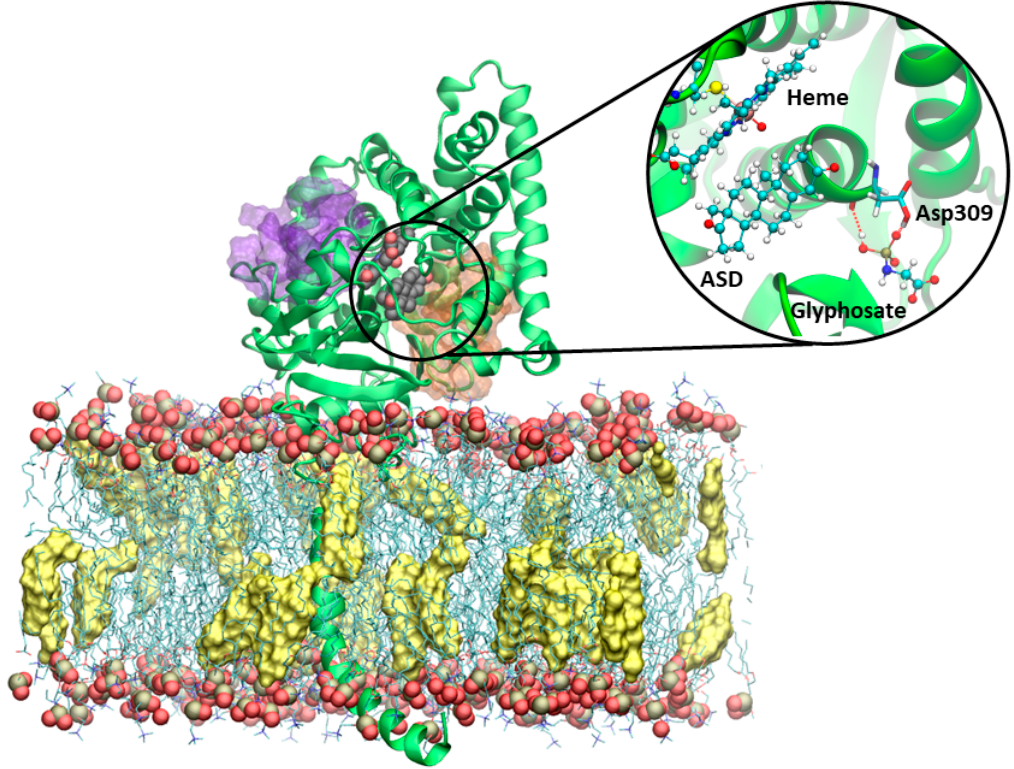
Figure 3. Representative structure of aromatase embedded in a POPC (1-palmitoyl-2-oleoyl-sn-glycero-3-phosphocholine) membrane, with phosphorous and oxygen atoms shown as tan and red van der Waals (vdw) spheres, and cholesterol (yellow surface) membrane. Sites 1 and 2 are shown as orange and purple transparent surfaces, respectively. The heme and androstenedione (ASD) are displayed in a vdw representation. The protein is shown as green new cartoons. The inset reports a close view of structure of aromatase in complex with glyphosate, as obtained from the most representative cluster of the molecular dynamics simulation trajectory. The heme moiety, ASD, and glyphosate are depicted in balls and sticks. The key catalytic residue Asp309, lining the binding cavity, is shown in licorice and colored by the atom name.